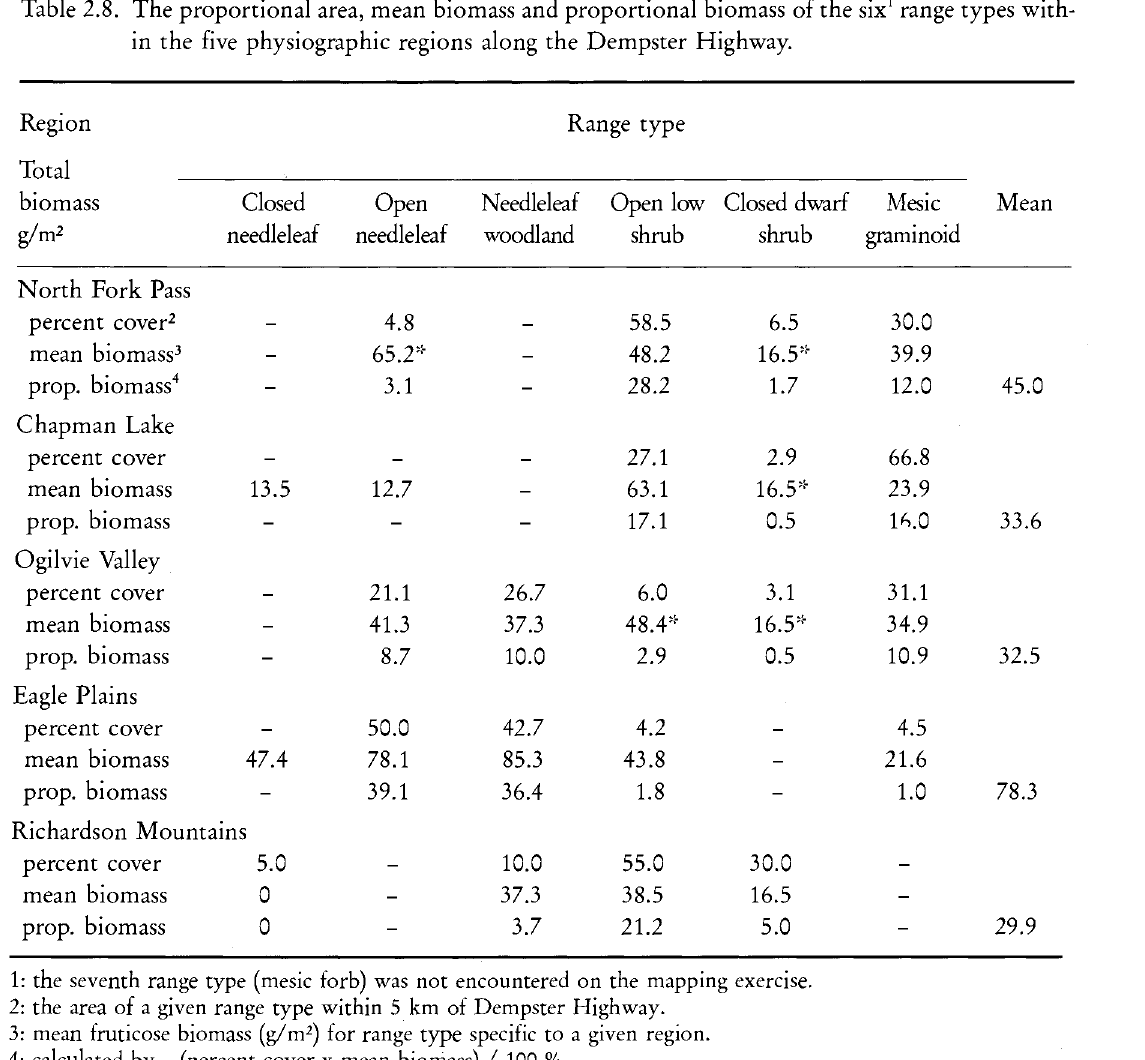
Table 2.8. The proportional area, mean biomass and proportional biomass of the six 1 range types with in the five physiographic regions along the Dempster